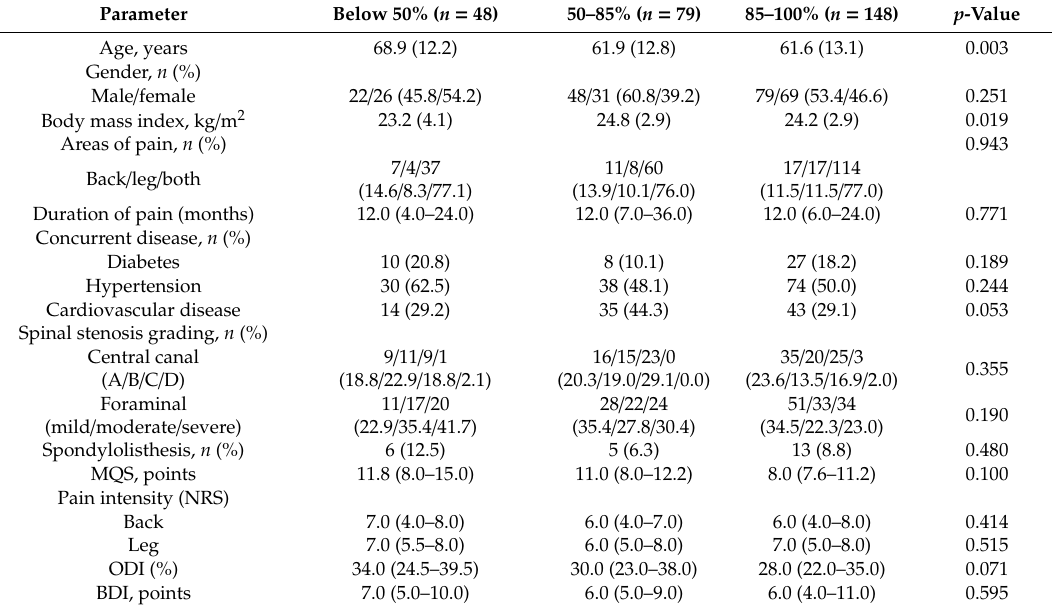
Table 1. Baseline characteristics of the study subjects according to the success rate of balloon adhesiolysis for multiple targets.